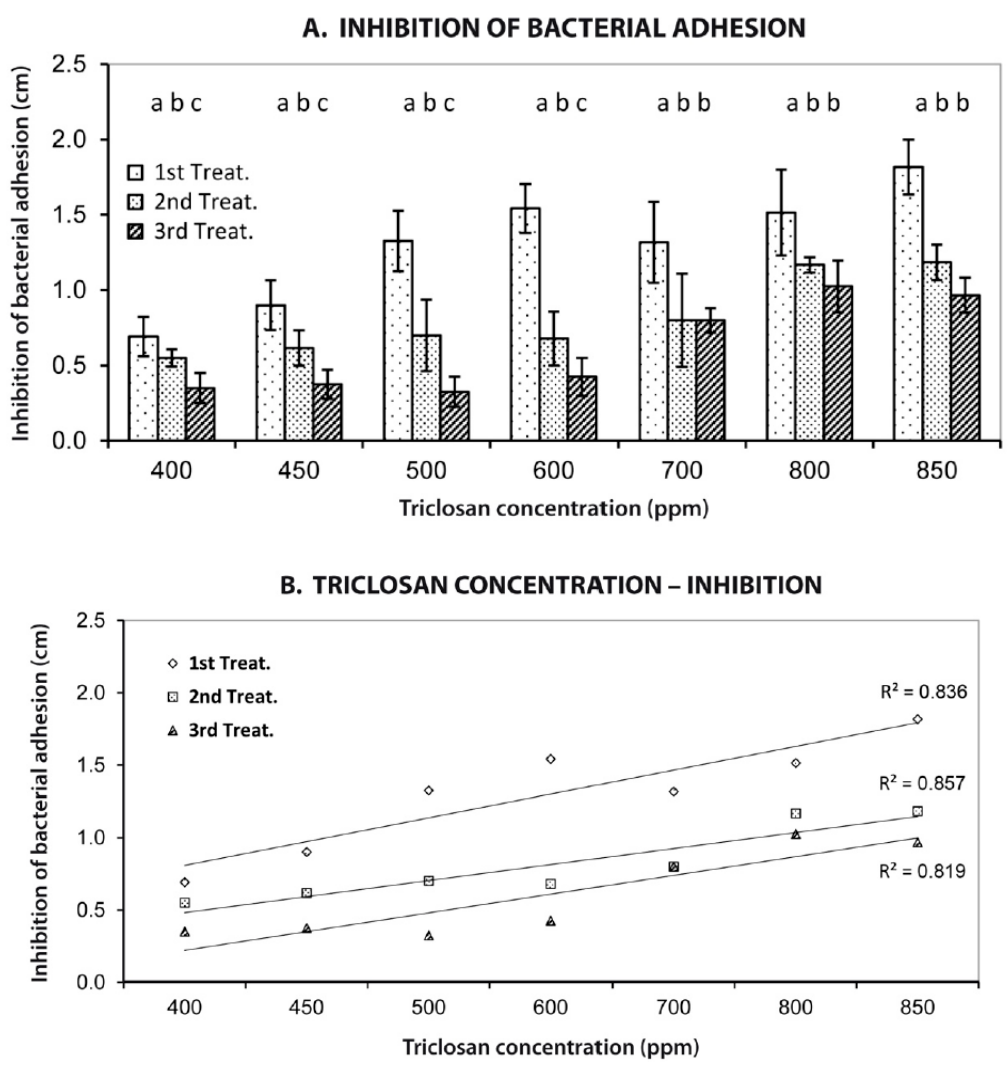
Figure 3. ( A ) Inhibition of the bacterial adhesion (cm) under wear condition of S. aureus on polyester surfaces treated with triclosan in concentrations between 400 ppm and 850 ppm. The wear condition performed on three successive washing/drying treatments for each concentration. Different letters of mean values over the bars (a, b, c) represent significant differences ( p < 0.05) between the treatments for each concentration. The error bars represent the standard error of means. ( B ) The relationship between triclosan concentrations and the inhibition of bacterial adhesion for each treatment is represented as the coefficient of determination (R 2 ). N = 9 for each result. Treat: Treatment.